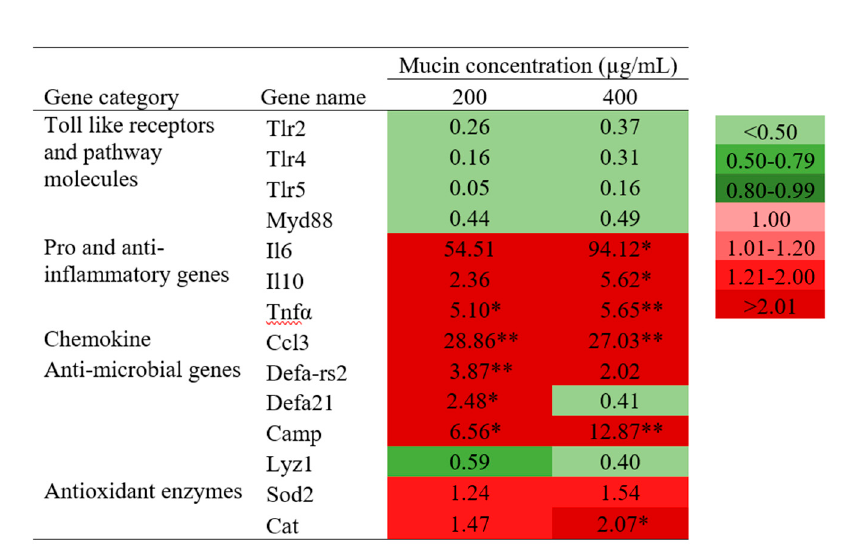
Figure 7. The relative mRNA expression of immune and antioxidant genes in PGM-treated RAW 264.7 cells. Cells were treated with PGM (200 and 400 µg/mL) for 24 h. The asterisk marks are used to indicate statistical significance compared with the control. Basal expression level was considered as 1.00-fold; upregulated and downregulated expressions were considered as >1.01 and <0.80-folds, respectively (one-way ANOVA, * P < 0.05, ** P < 0.01).